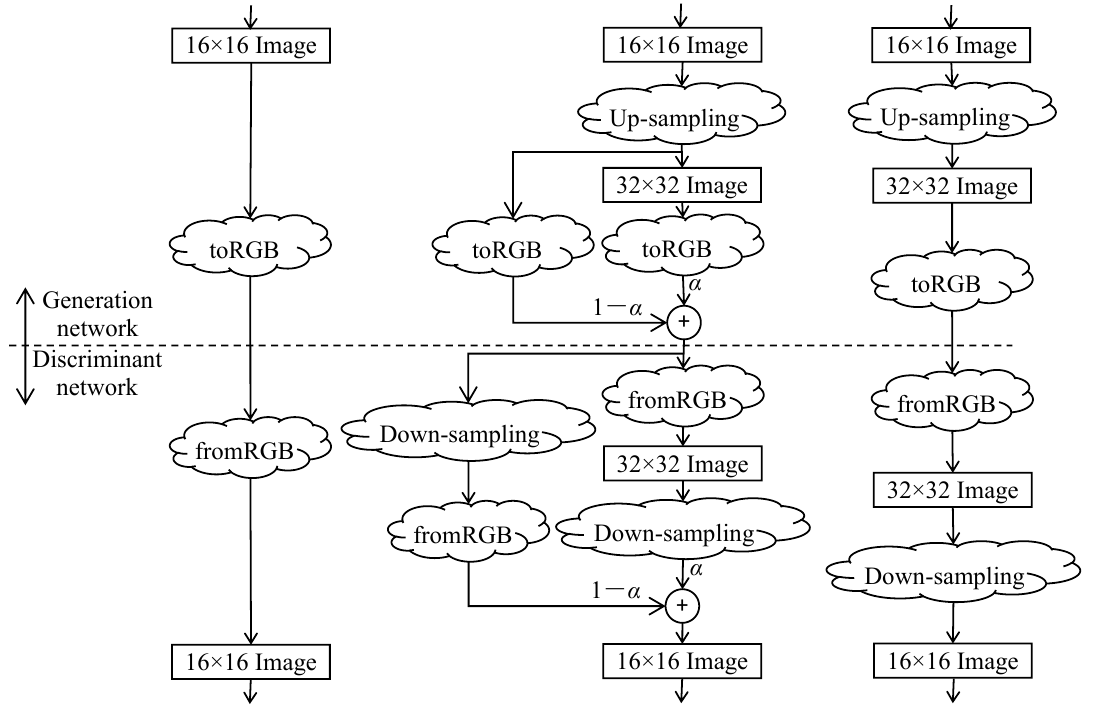
Figure 8. The framework of PGGAN. α will increase continuously during the training process, thus realizing a slow increase in the degree of upsampling. Note that this figure represents only one layer of the network, and the actual training process needs to stack several similar